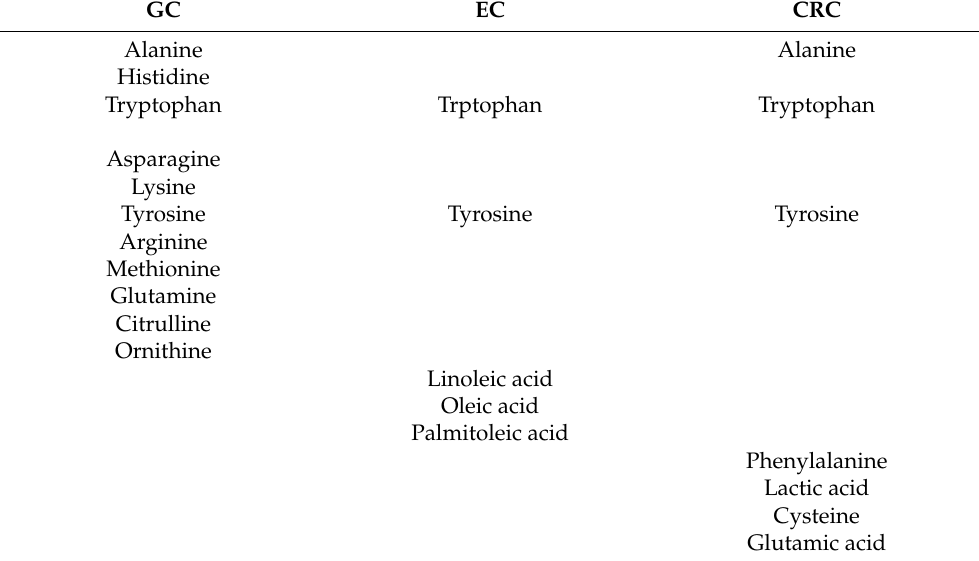
Table 9. Comparison of the three cancers, GC, EC and CRC based on their respective altered metabo- lites. GC EC CRC Alanine